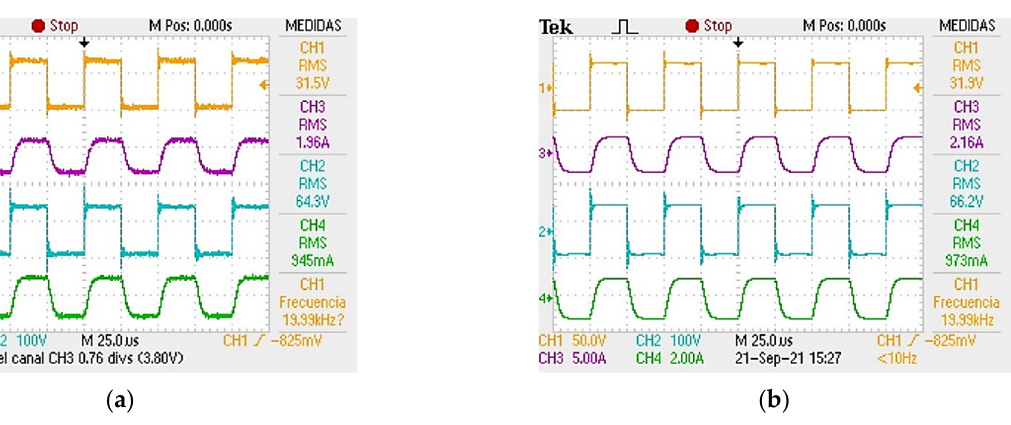
(Mosfets), ( c ) DSP, ( d ) a 12V DC source, ( e ) MFT, ( f ) Load, and ( g ) Oscilloscope.